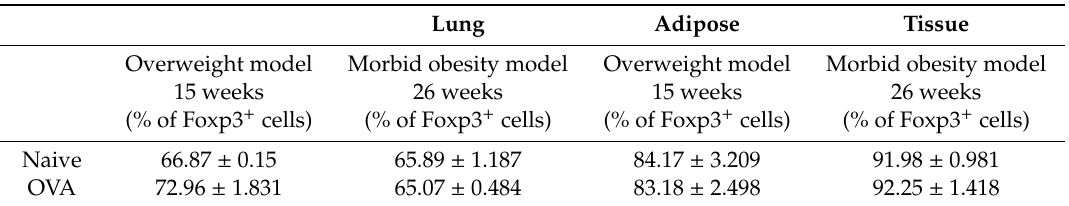
Table 1. The expression of Helios in lung and adipose tissue Foxp3 + Tregs from the DIO mouse model at 15 and 26 weeks.